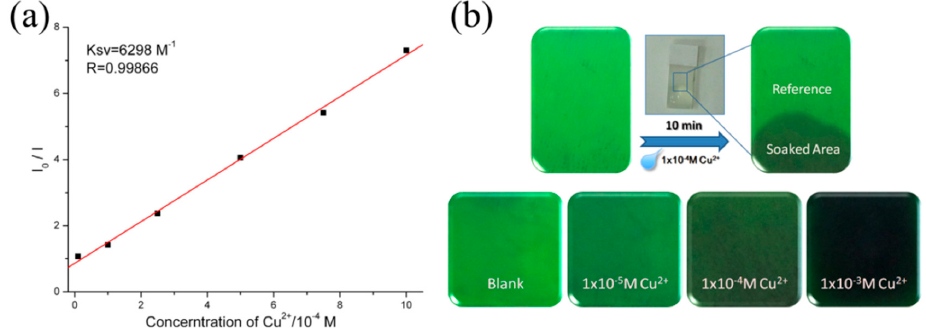
Figure 16. ( a ) Stern–Volmer plot of the Tb-Succinate MOF film sensing of Cu 2+ at the range from 1 × 10 − 5 to 1 × 10 − 3 M. The line represents the linear fit of the data; ( b ) Photographs of the Tb-Succinate film before and after the addition of different Cu 2+ solutions under UV-light radiation at a wavelength of 254 nm. Reprinted with permission from Reference [91]. Copyright 2015 Elsevier.